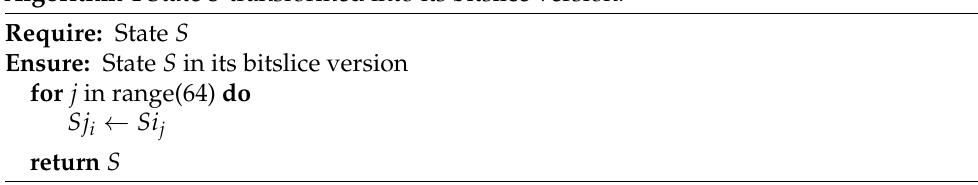
Algorithm 4 State S transformed into its bitslice